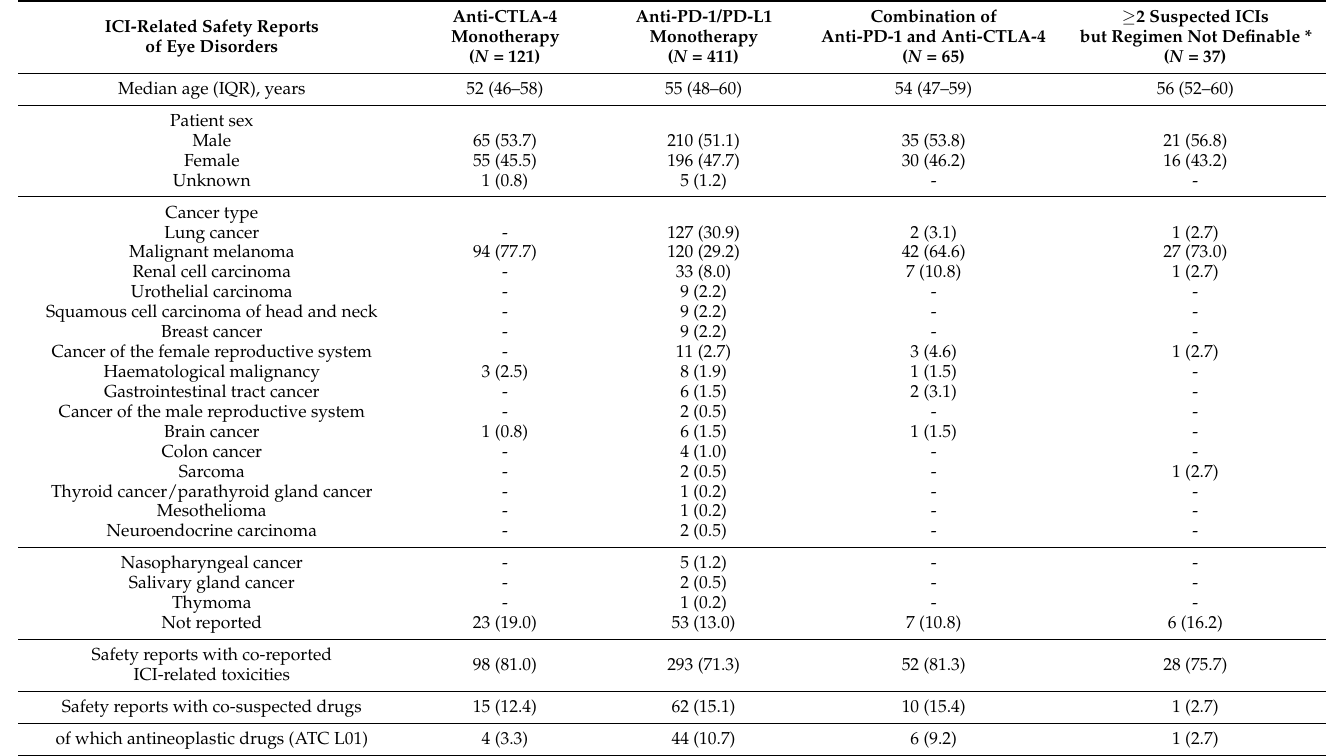
Table 2. Characteristics of safety reports of eye disorders reported with immune checkpoint inhibitors in the age subgroup 18–64 years.